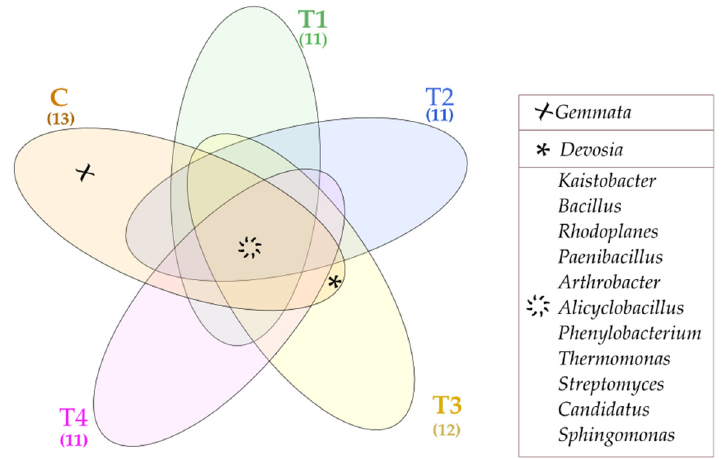
Figure 4. Relative abundance of the predominating bacterial genera in the soils tested with the difference between ratios at ≥ 1%. Tebuconazole doses in mg kg − 1 : C—control soil, T1—0.01 mg, T2—0.1 mg, T3—0.5 mg, T4—1.0 mg.